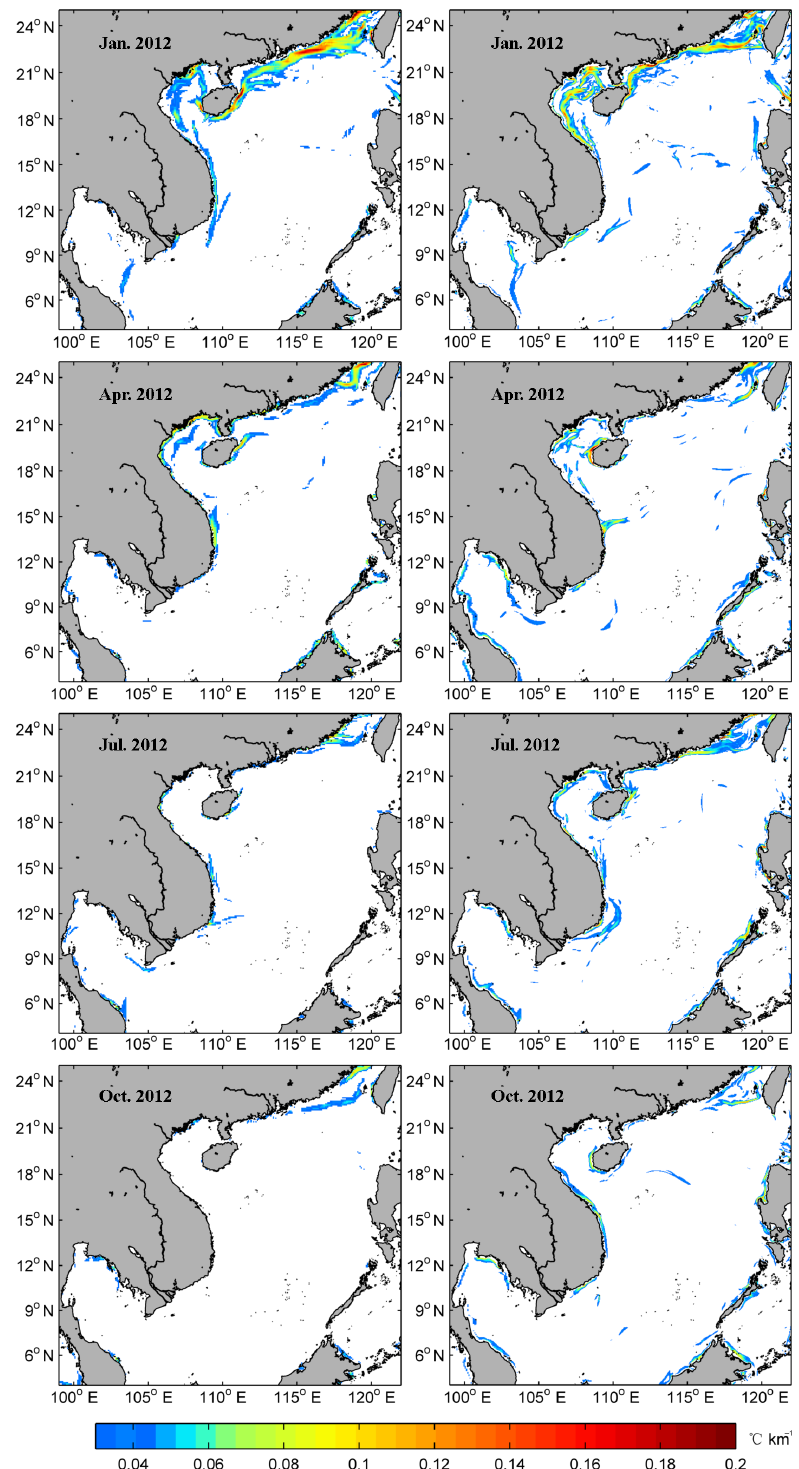
Figure 10. The distributions of SST fronts in the SCS from Mercator Océan (left panels) and SCSOFS (right panels) in January, April, July, and October